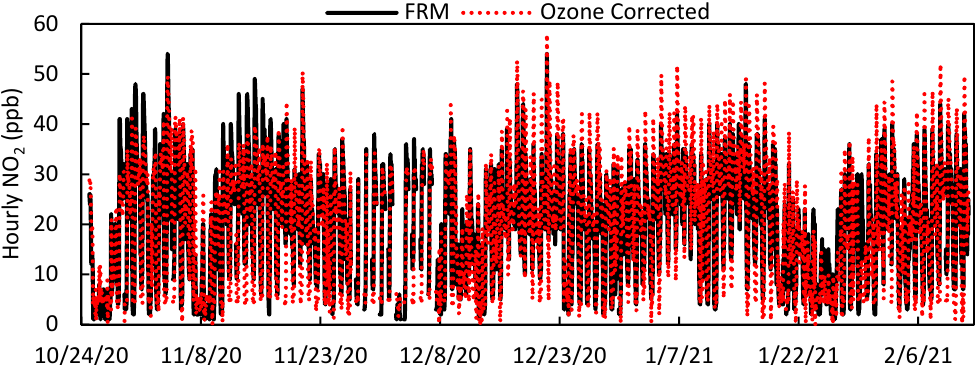
Figure 11 . Time series of hourly West Phoenix FRM NO 2 and LCS #2 Ozone corrected 30-day calibrated NO 2 values for the entire deployment period.